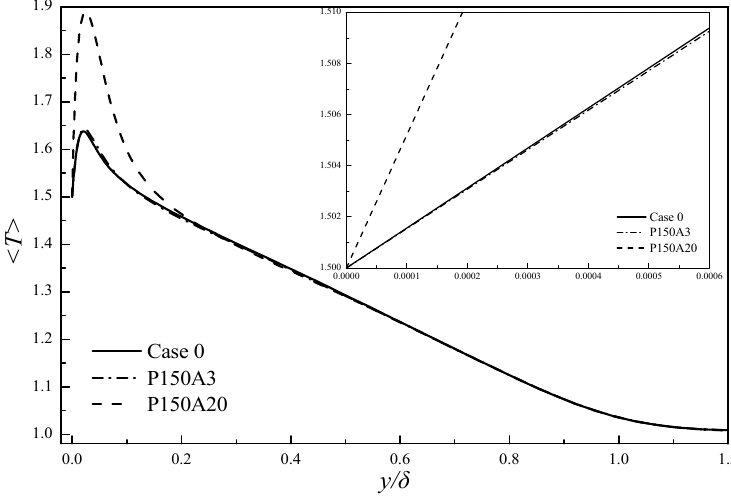
Figure 11. Mean temperature profile at x = 40.775.